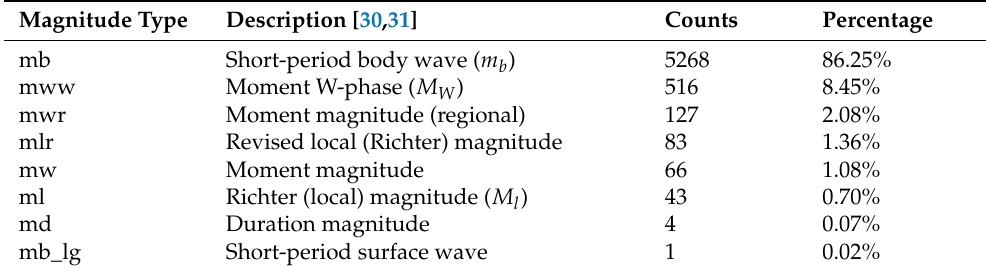
Table 1. Magnitude types found in the USGS earthquakes database, indicating the counts and relative abundance for each of